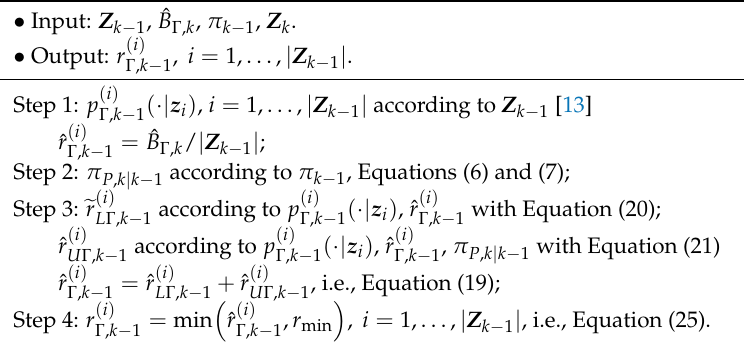
Table 1. Modeling of the target birth